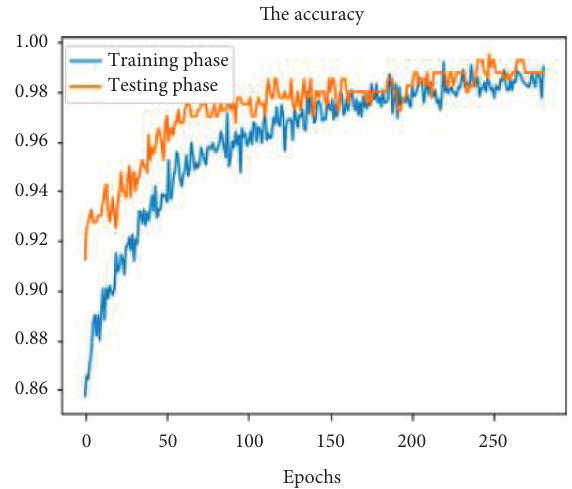
Figure 8: The accuracy behavior during the training and the testing phases.